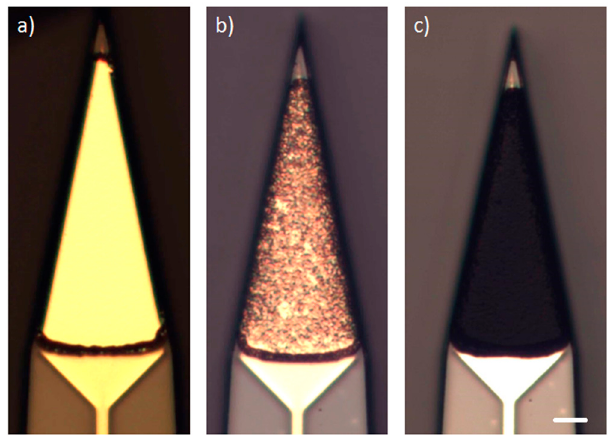
Figure 8. Microscopic top view of the microelectrodes (3000 µm 2 ) at the probe tip showing ( a ) smooth electroplated gold surface after microfabrication; ( b ) rough gold surface after etching in 0.05 mol/L iodine solution for 60 s; ( c ) PEDOT:PSS coated microelectrode (scale bar 10 µm).